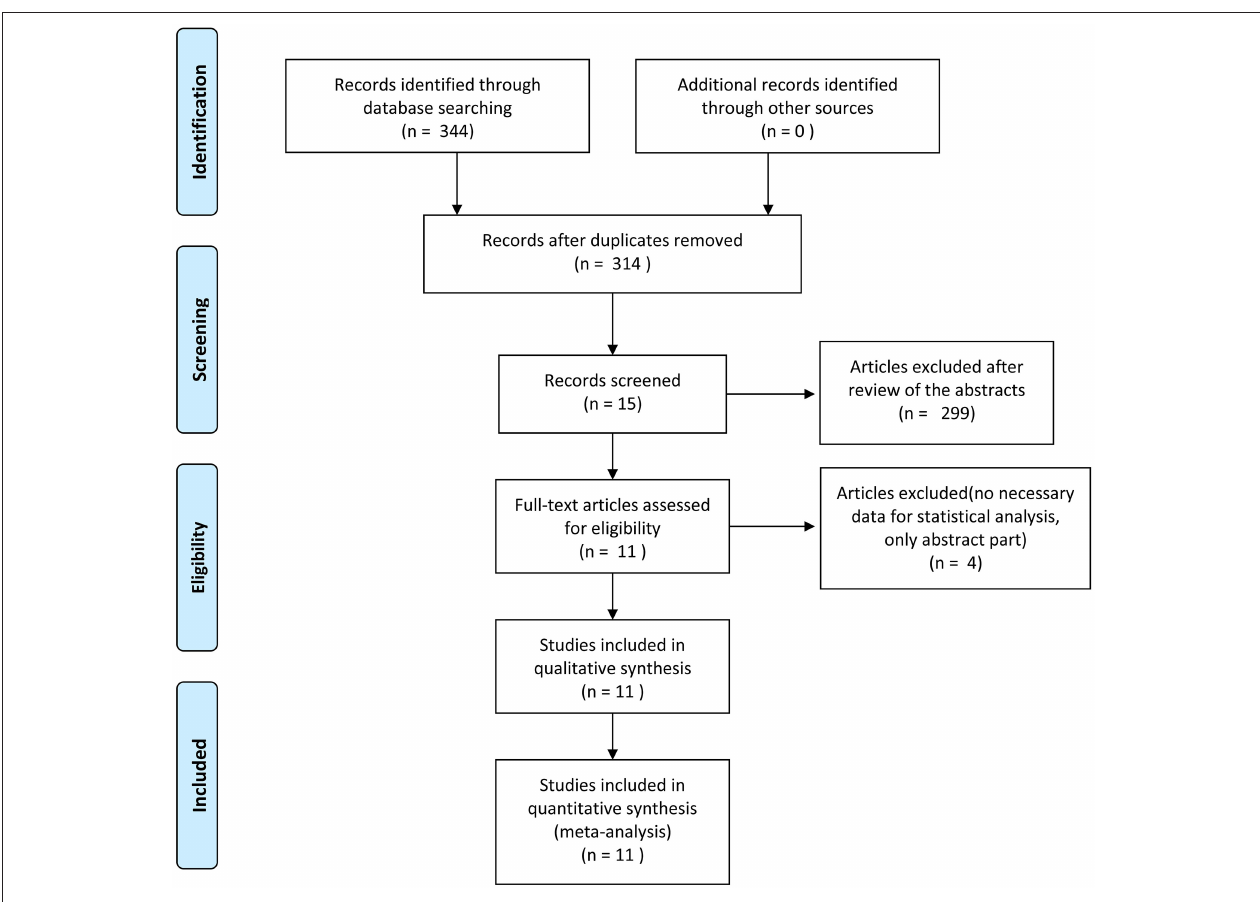
FIGURE 1 | Flow chart for study